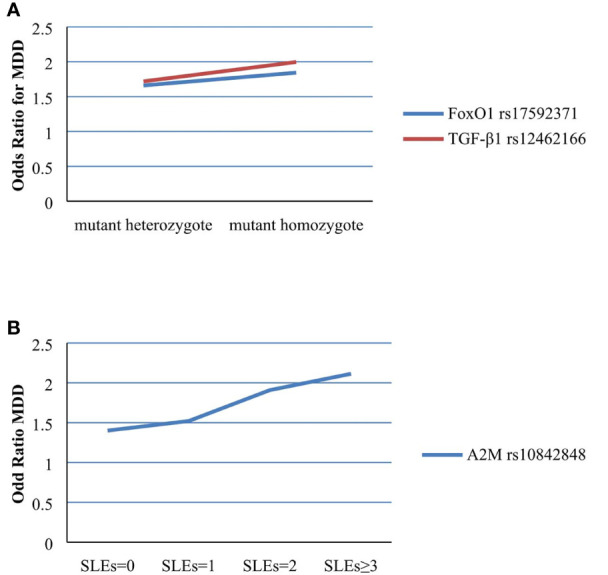
(A) Effect of SLEs on MDD in different genotypes of rs17592371 in FoxO1 and rs12462166 in TGF-β1. (B) Effect of rs10842848 in A2M on MDD in different number of SLEs.